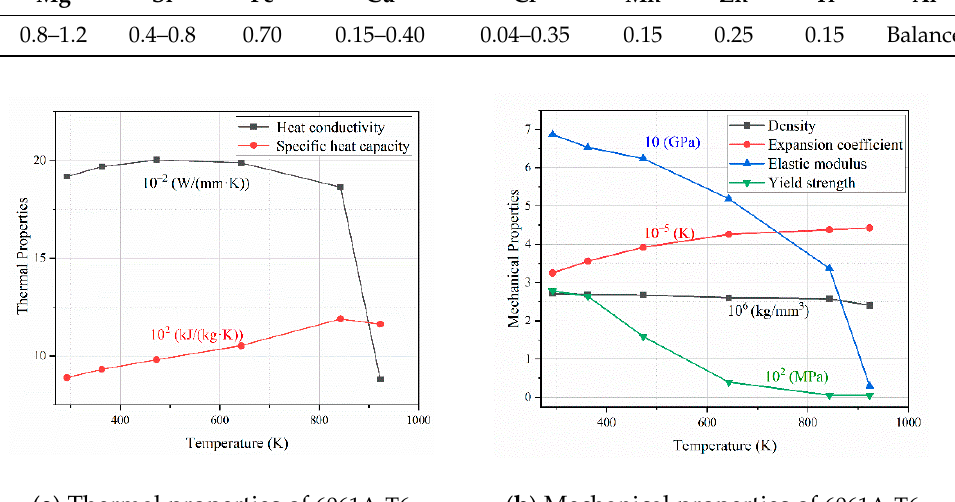
Table 1. Chemical composition of 6061A-T6 (wt.%).